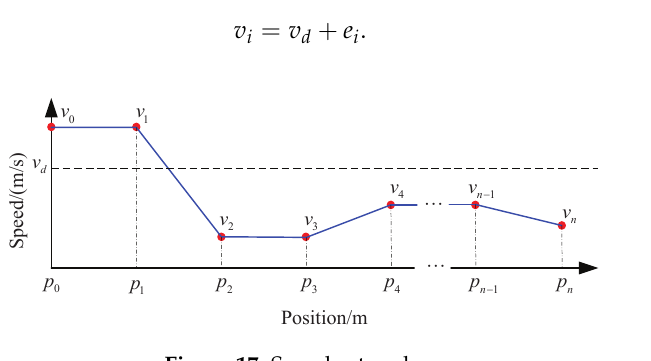
Figure 17. Speeds at